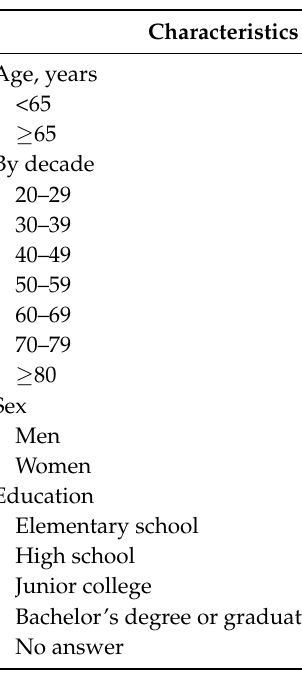
Table 1. Characteristics of the respondents, N =